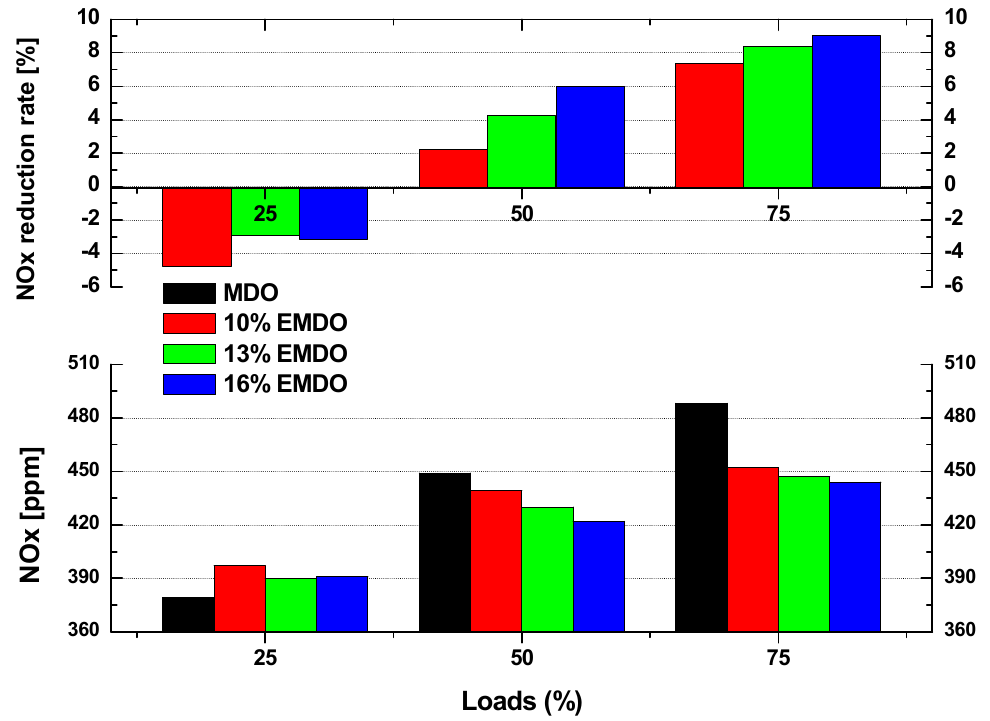
Figure 10. NOx reduction characteristics according to load and rate of water concentration of MDO.